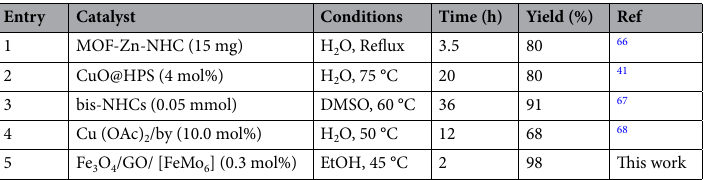
Table 3. A comparison study between the performance of Fe 3 O 4 /GO/[FeMo 6 ] and former catalysts in the synthesis of carboxylic